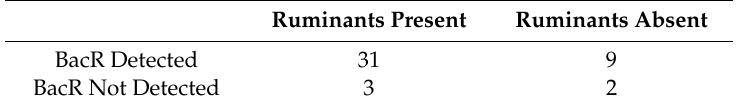
Table A3. Self-reported presence of ruminants with detection of BacR molecular marker.